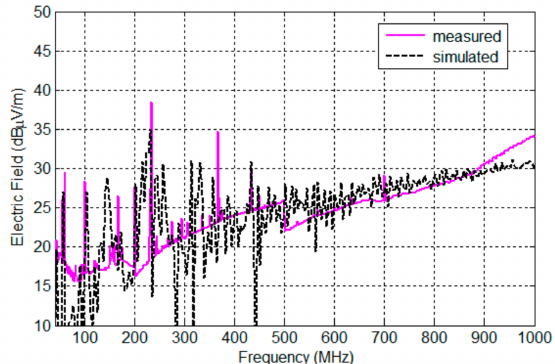
Figure 9. Validation of the electromagnetic model through radiated emission test: frequency-domain spectrum of the simulated and measured electric field at 3